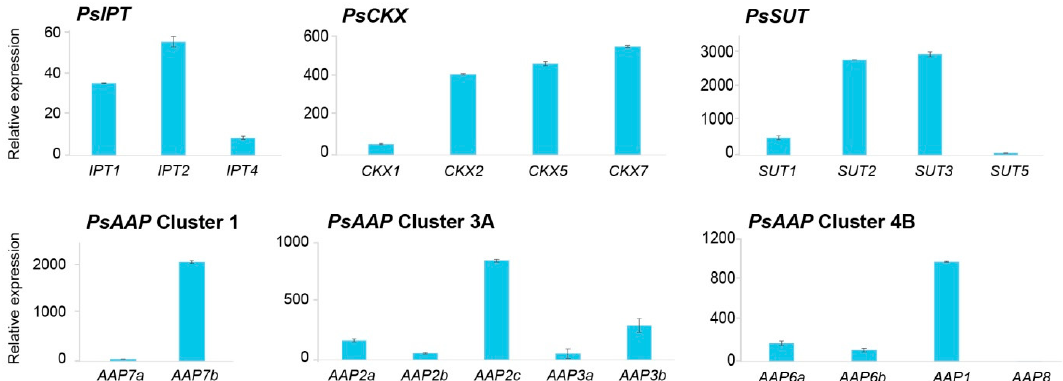
Figure 3. Relative expression of gene families in the ovule of P. sativum L. cv Bolero plants one day before fertilisation. Data are from reverse transcription quantitative PCR (RT-qPCR) and are given as fold-change values relative to the reference genes PsEF , PsGAP , and PsACT . IPT : isopentenyl transferase; CKX : cytokinin oxidase/dehydrogenase; SUT : sucrose transporter; AAP : amino acid permease. The results are expressed as ± standard deviation (SD).